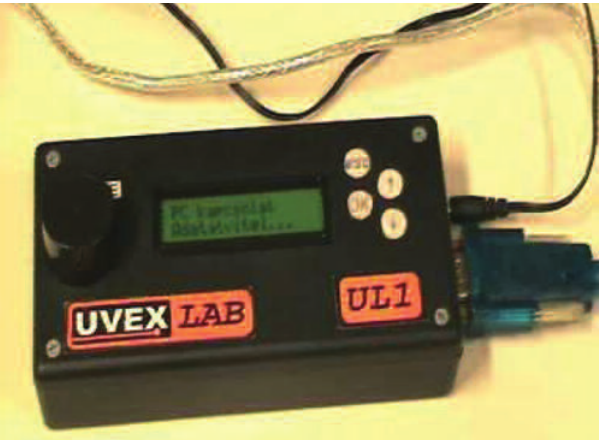
Figure 2. UVEX UL-1, the portable laboratory implement for the quick measurement of the anthocyanin content of sour cherry